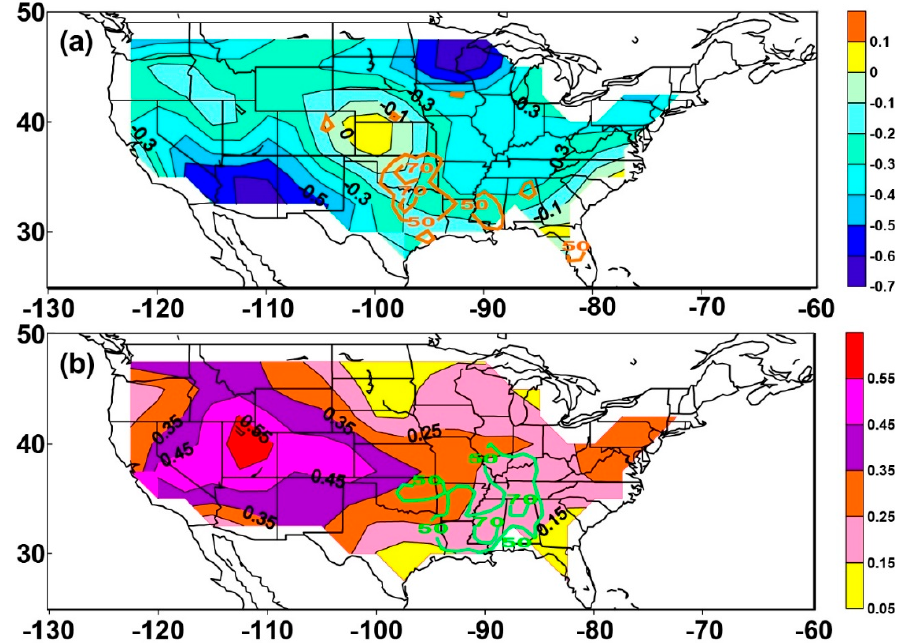
Figure 2. Composites of surface air temperature anomaly (°C) over time periods of ( a ) 1959 to 1988, and ( b ) 1989 to 2018. The Tornado Alley is defined as the core area of (E)F1-(E)F5 tornado counts of 50 or more per 1° × 1° grid box over a 30-year period with orange color in ( a ) and green color in ( b ).